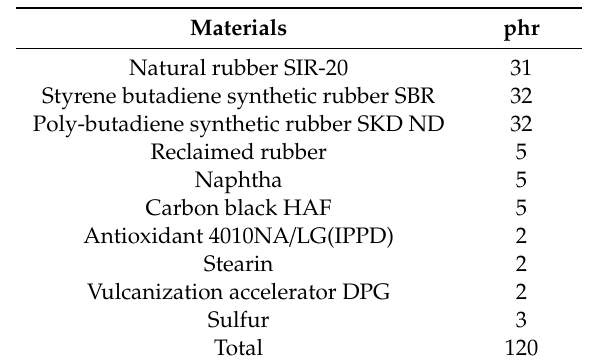
Table 1. The ATRBZ rubber structure.